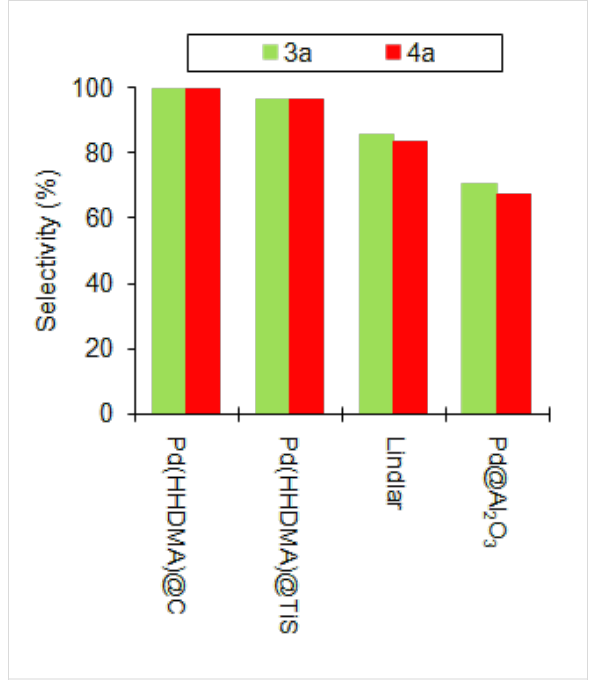
Figure 14: Selectivity of the continuous-flow partial hydrogenation reaction of 3 and 4 over packed-bed Pd catalysts at the same conver- sion level. Data from ref. [121].